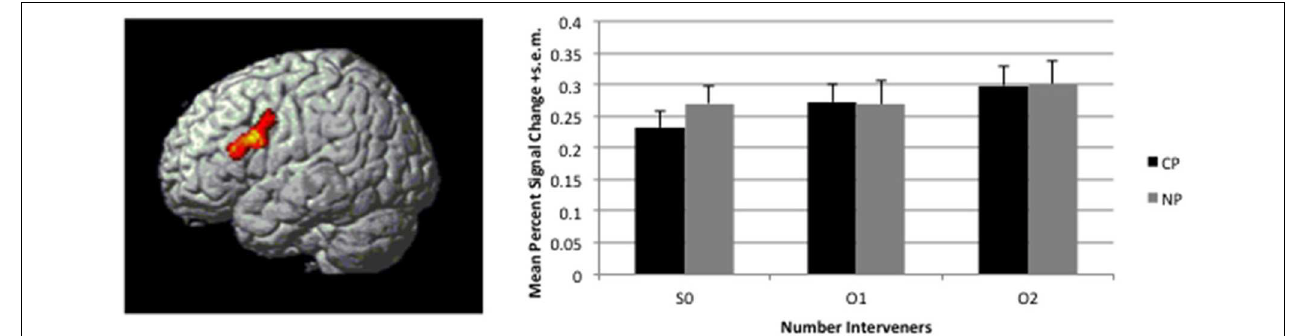
FIGURE 4 | Linear effect of distance (S0 < O1 < O2) observed in the 2Type(CP, NP) × 3Number(S0, O1, O2). Map is thresholded at voxel-wise p < 0 . 005 and corrected for multiple comparison through cluster size p < 0 . 05 . Activation is overlaid on a rendered